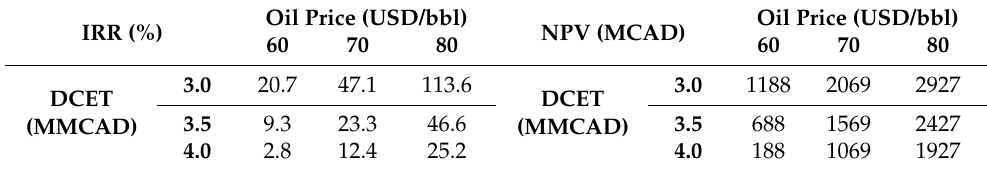
Table 3. Cardium Economics Sensitivity Analysis with respect to oil price and DCET cost.